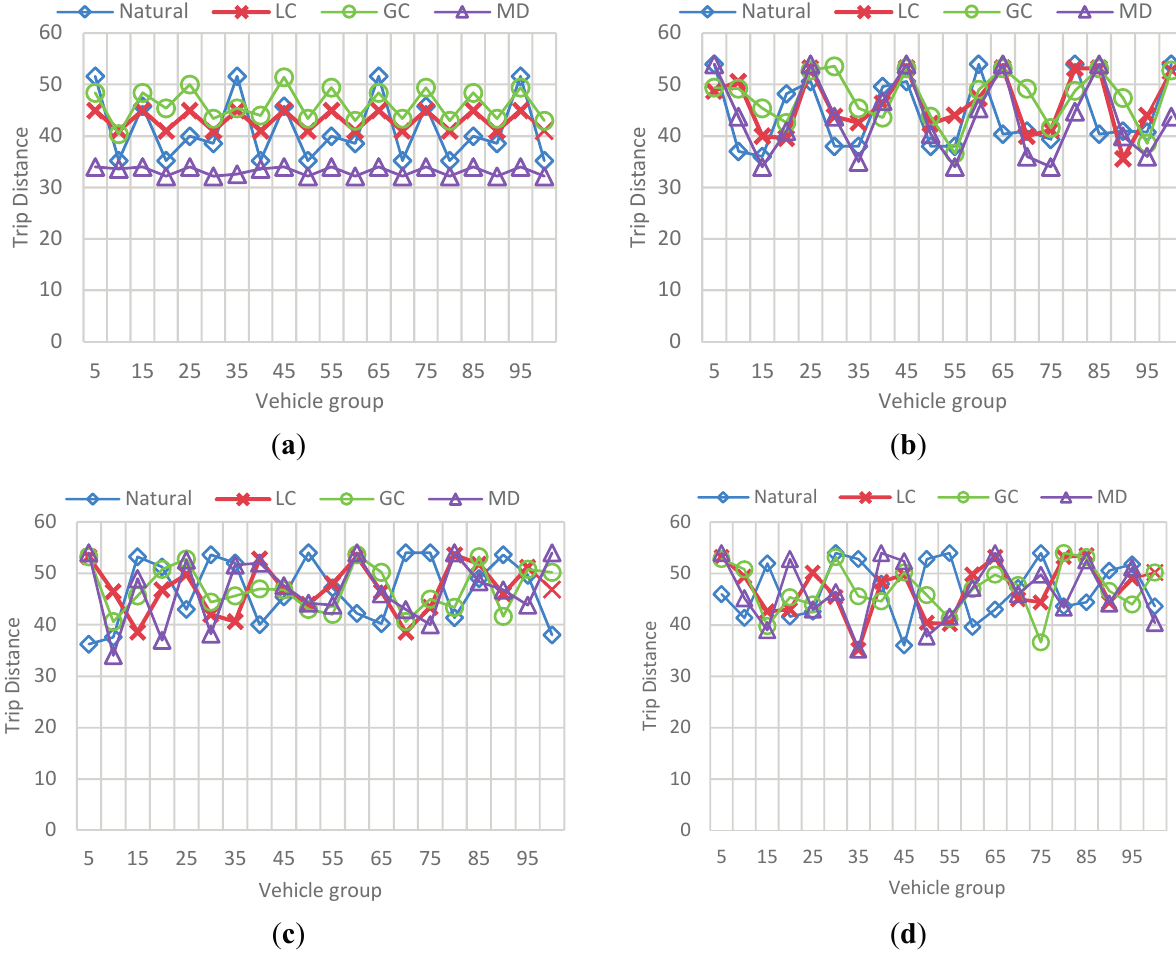
Figure 25. Behavior for trip distance in the F-vehicles scenario. ( a ) Mean trip distance value for each 5-vehicles set when F is 10; ( b ) Mean trip distance value for each 5-vehicles set when F is 20; ( c ) Mean trip distance value for each 5-vehicles set when F is 10; ( d ) Mean trip distance value for each 5-vehicles set when F is 20.